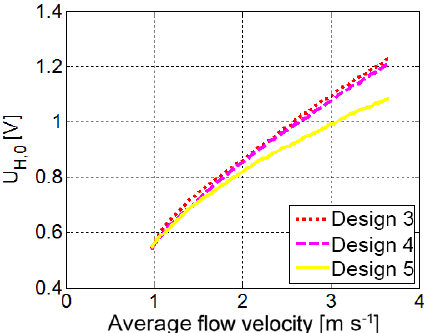
Figure 10. Comparison of the output characteristic of three differ- ent transducer designs (calorimetric approach) where perforations between the copper leads were added. Design 3 does not have any perforations; design 4 exhibits hole diameters of 100µm and 300µm spacing between the holes. In design 5, the spacing is reduced to 100µm with the same hole diameter as in design 4.